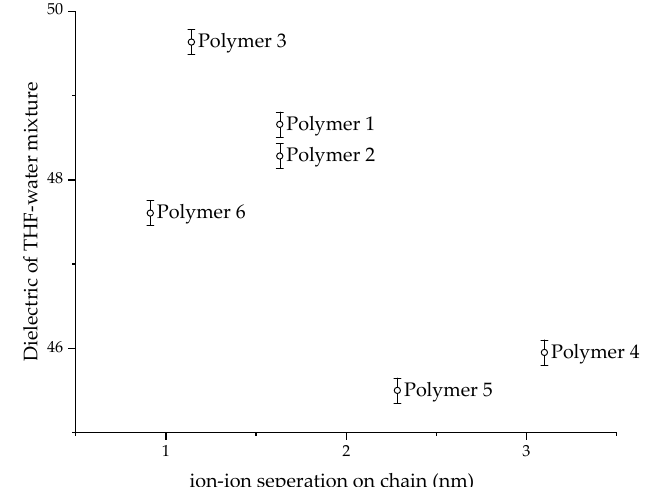
Figure 12. The dielectric of THF/water mixture at collapse point against ion–ion separation on the polymer chain.